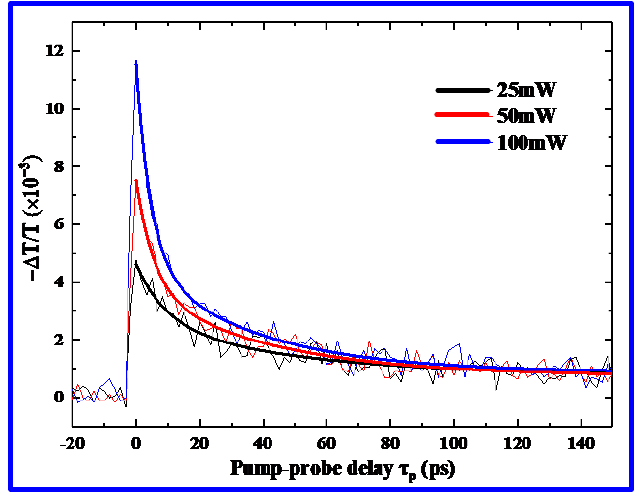
Figure 6. Carrier transient dynamics of 2D (PEA) 2 (MA) 2 Pb 3 I 10 perovskite film at different pump powers (The thin and thick solid curves correspond to the measured and fitted results).